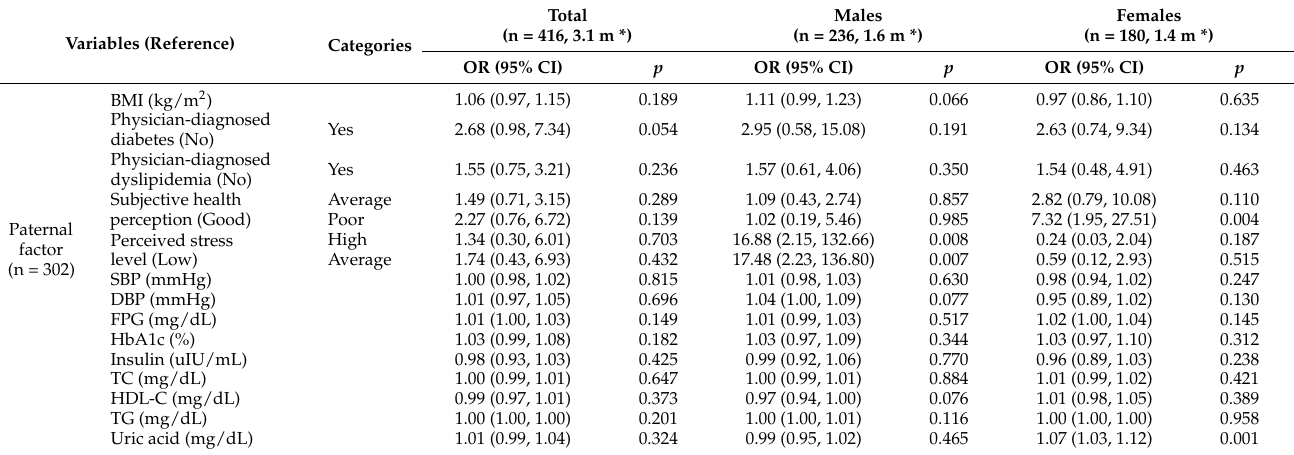
Table 4. Paternal Factors Affecting the High-risk Group for Adolescent